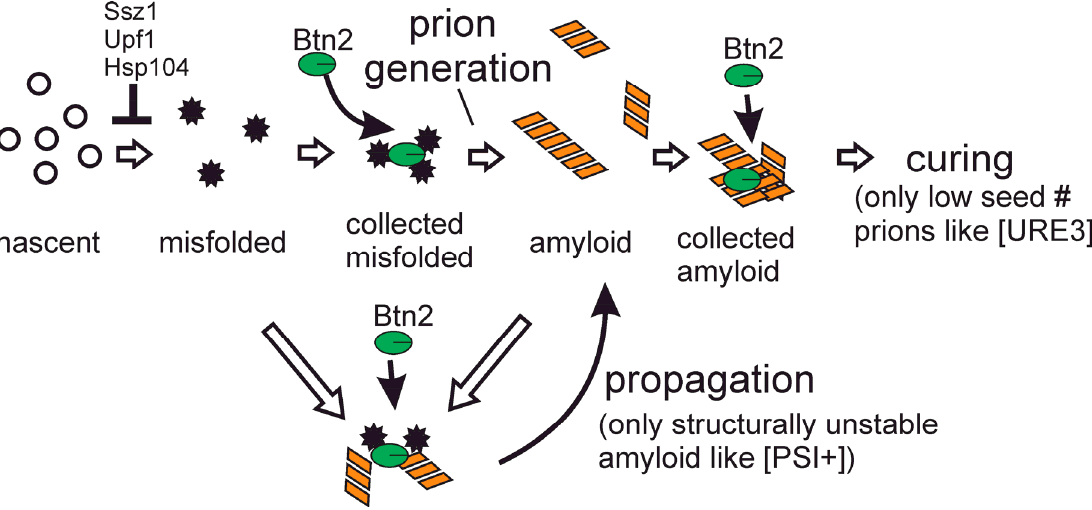
Figure 4. Speculative explanation for the different effects of Btn2 on [URE3] and [PSI+] [65]. Btn2 collects amyloid filaments (of Ure2 and Sup35) and non-amyloid misfolded proteins. Ure2 amyloid is far more stable and has generally lower seed number than that of Sup35. Btn2 cannot collect all the seeds of [PSI+] but by collecting misfolded Sup35 molecules may facilitate prion formation. Ure2 does not need any help to form its very stable amyloid. Thus, Btn2 sequesters the filaments of low copy number [URE3] prions but cannot collect all the Sup35 filaments. Figure from [65].